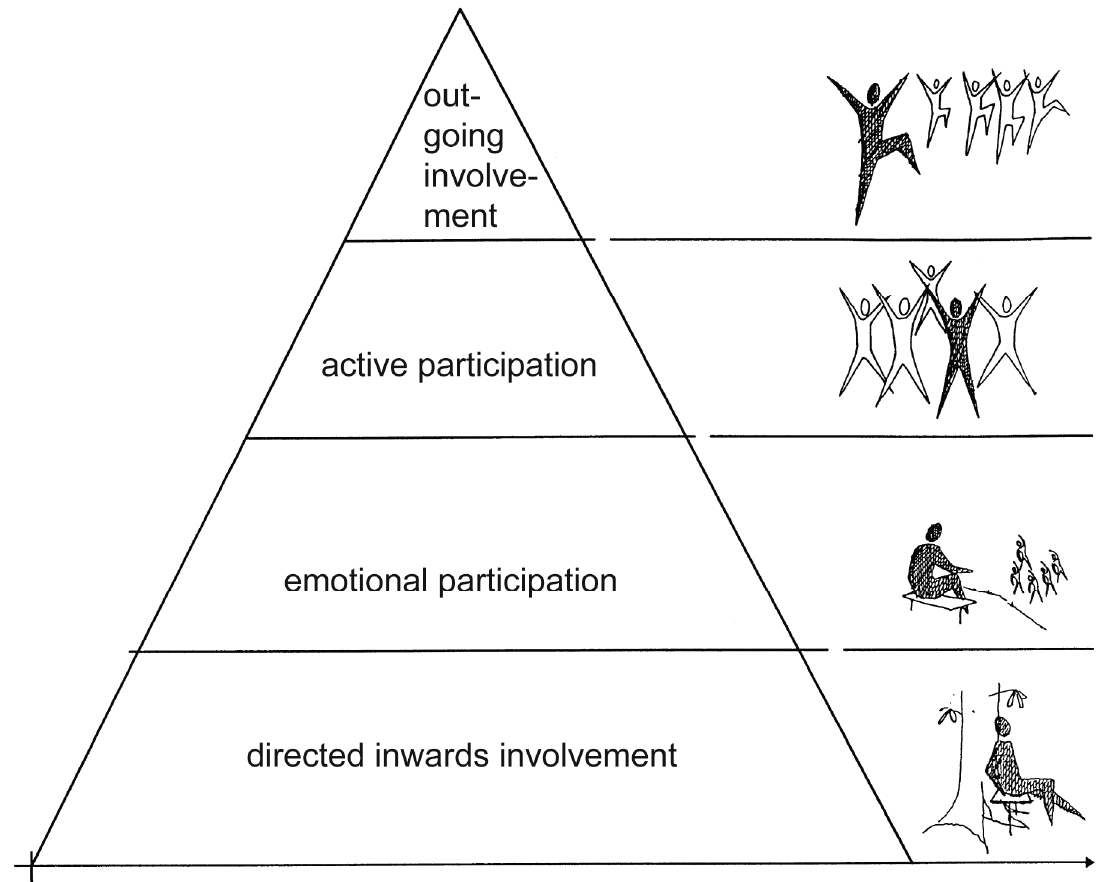
Figure 3. Pyramid of supporting environments and levels of function and coping